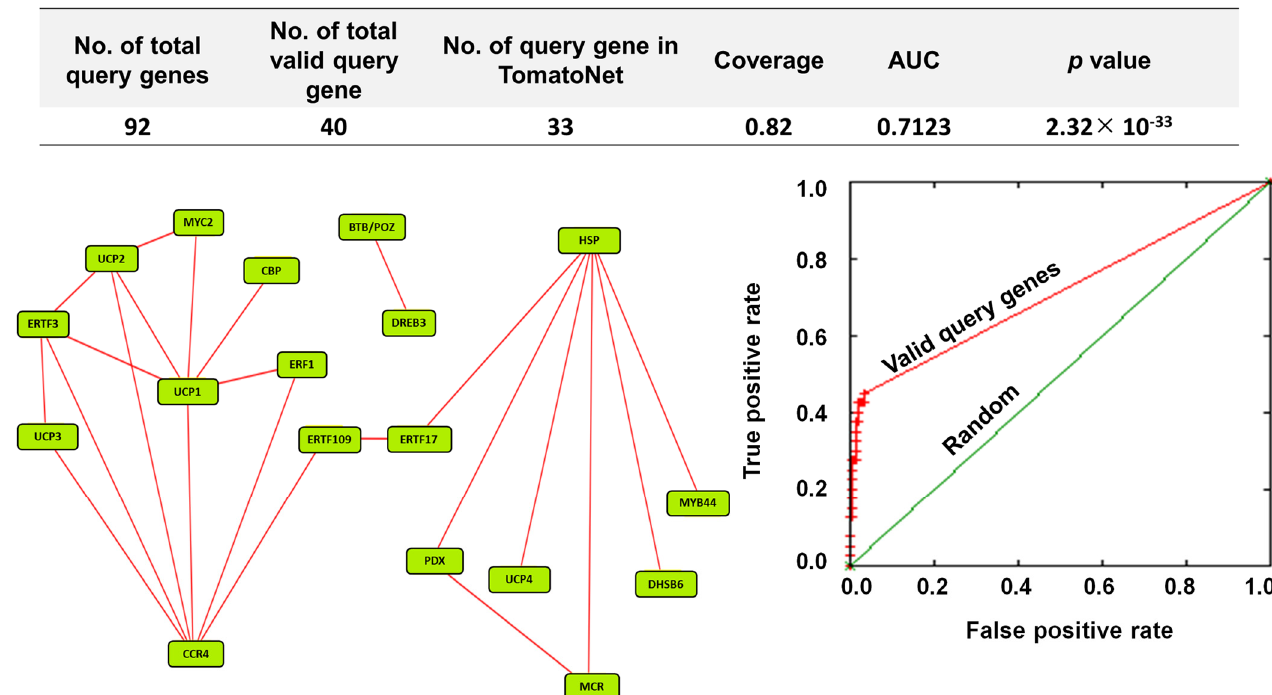
Figure 7. A co-functional network analysis of stress-responsive DEGs validates β CC’s role in the regulation of multiple stress-responsive genes. Top and left panel: Among 92 upregulated stress-responsive DEGs, 40 queries were valid. From these, 33 valid queries were present in TomatoNet. Among them, 18 stress-responsive genes are co-functional. Right panel: Co-functional network is validated by receiver operating characteristics (ROC) curve where the area under curve (AUC) value is 0.7123 at p = 2.3 × 10 − 33 . For better visualization, the positions of the nodes were rearranged. CCR4, probable CCR4-associated factor 1 homolog 9; HSP, heat shock 70 kDa protein 8; UCP1, uncharacterized protein LOC101261732; UCP2, uncharacterized protein LOC104645686; ERTF3, ethylene-responsive transcription factor 3; UCP3, uncharacterized protein LOC101254906; PDX, pyridoxal 5 (cid:48) -phosphate synthase-like subunit PDX1.2; MCR, BAG family molecular chaperone regulator 5, mitochondrial-like; MYC2, transcription factor MYC2; ERTF17, ethylene-responsive transcription factor ERF017; DHSB, DNAJ homolog subfamily B member 6-like; DREB3, dehydration-responsive element binding protein 3; BTB/POZ, BTB/POZ and MATH domain-containing protein 2-like; UCP4, uncharacterized protein LOC101245195; ERF1, ethylene- responsive transcription factor1; MYB44, transcription factor MYB44; ERTF109, ethylene-responsive transcription factor ERF109-like; CBP, probable calcium-binding protein